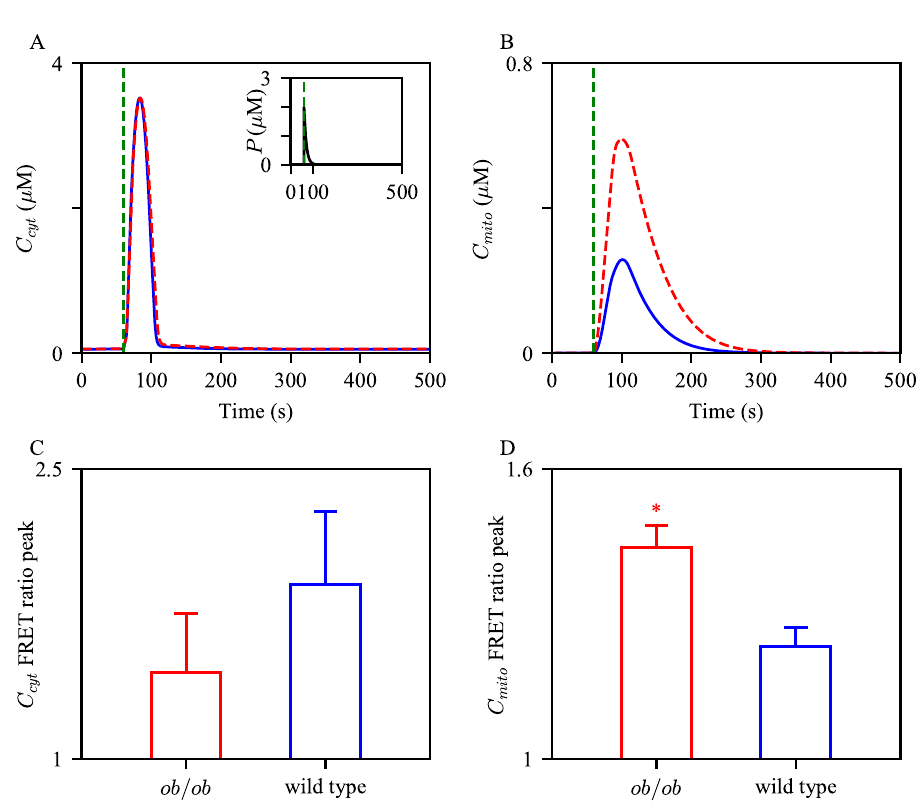
Fig 7. Effects of cellular changes associated with obesity on amplitudes of cytosolic and mitochondrial Ca 2+ transients. The control model and the obesity model was given a pulse of IP 3 , Eq 55 with M = 10, t 0 = 100, and Δ = 0.2, shown by the inset graph in (A). The cytosolic Ca 2+ trajectories are shown in (A), while mitochondrial Ca 2+ are shown in (B). The blue solid curves are the solutions from the control model, and the red dashed ones are from the obesity model. The green dashed vertical lines indicate the pulsing time. The bottom panels show the quantification of (C) cytosolic and (D) mitochondrial Ca 2+ FRET ratio peaks in wild type and ob / ob hepatocytes. The experimental data were obtained from Arruda et al. [9]. � Student’s t-test p -value < 0.05.